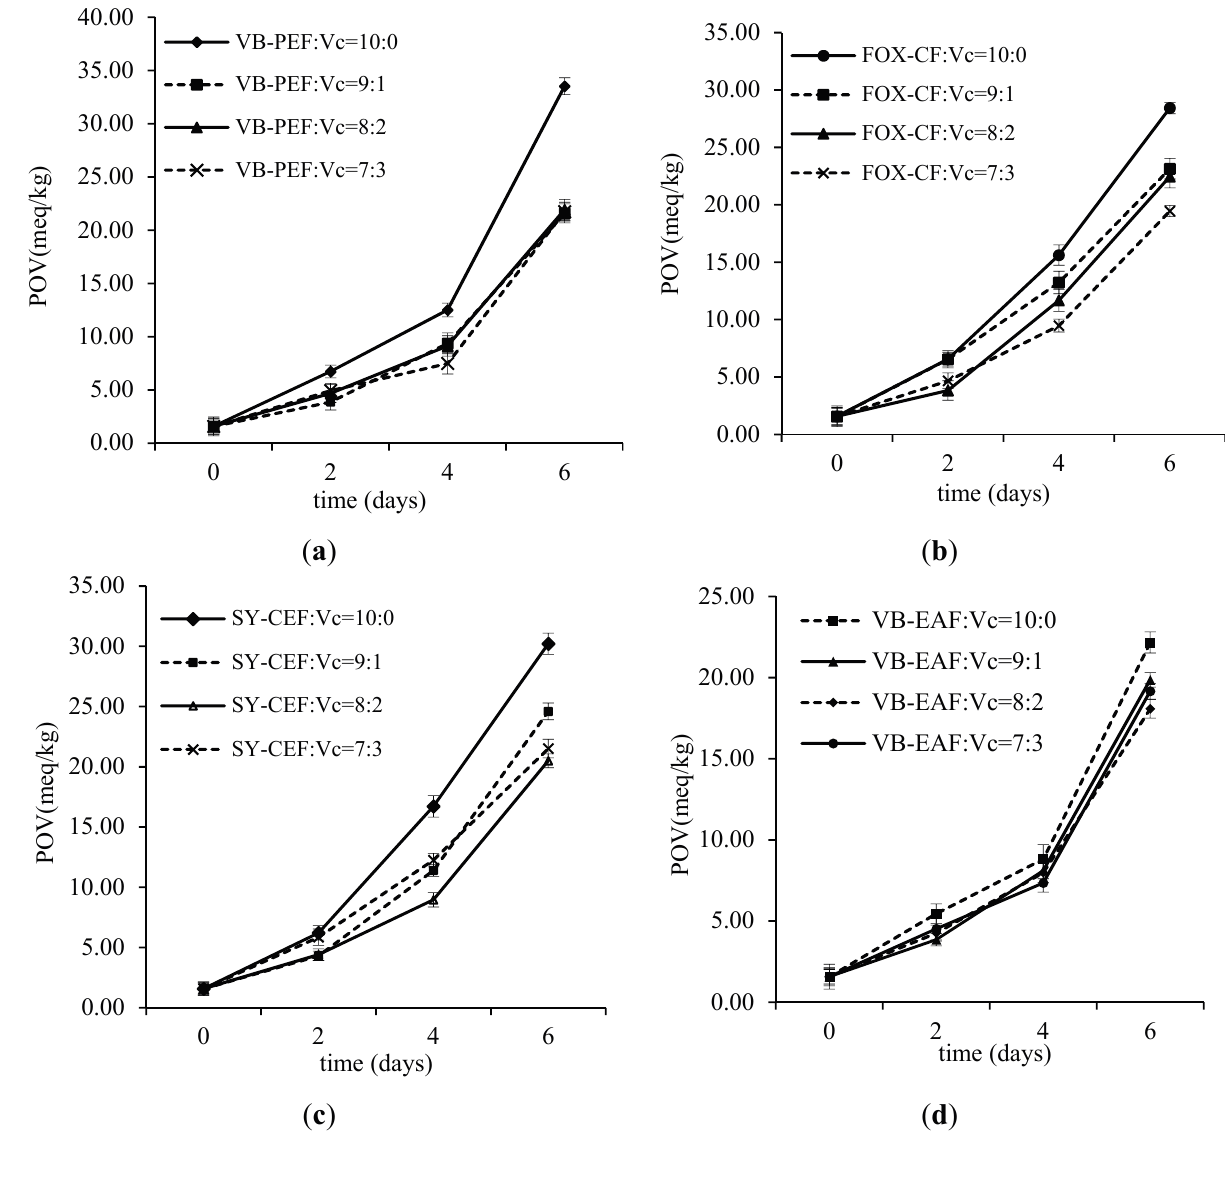
Figure 1. Peroxide value (POV) of edible oils at the ratios of 10:0, 9:1, 4:1, 7:3 of VB-PEF ( a ), FOX-CF ( b ), VB-EAF ( c ), SY-ME ( d ), respectively, with vitamin C, during storage at 70 ± 1 °C for 6